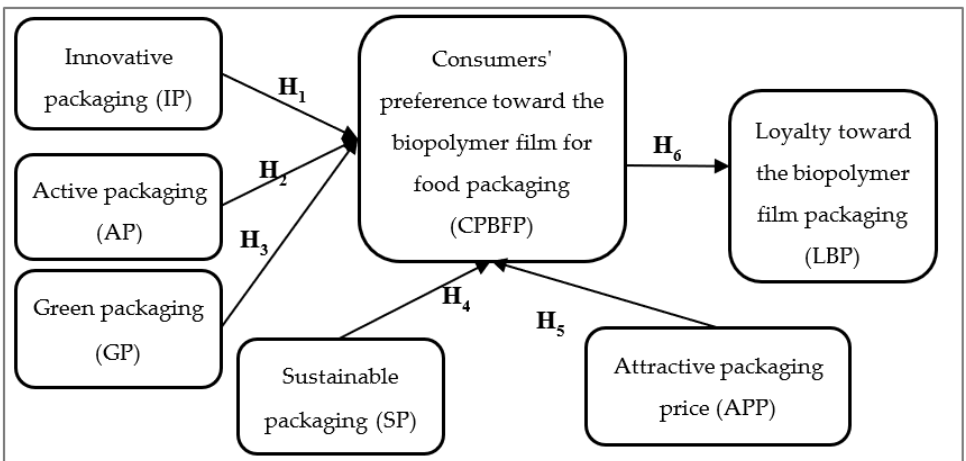
Figure 2. Conceptual model: Generating loyalty towards a biopolymer-film packaging.